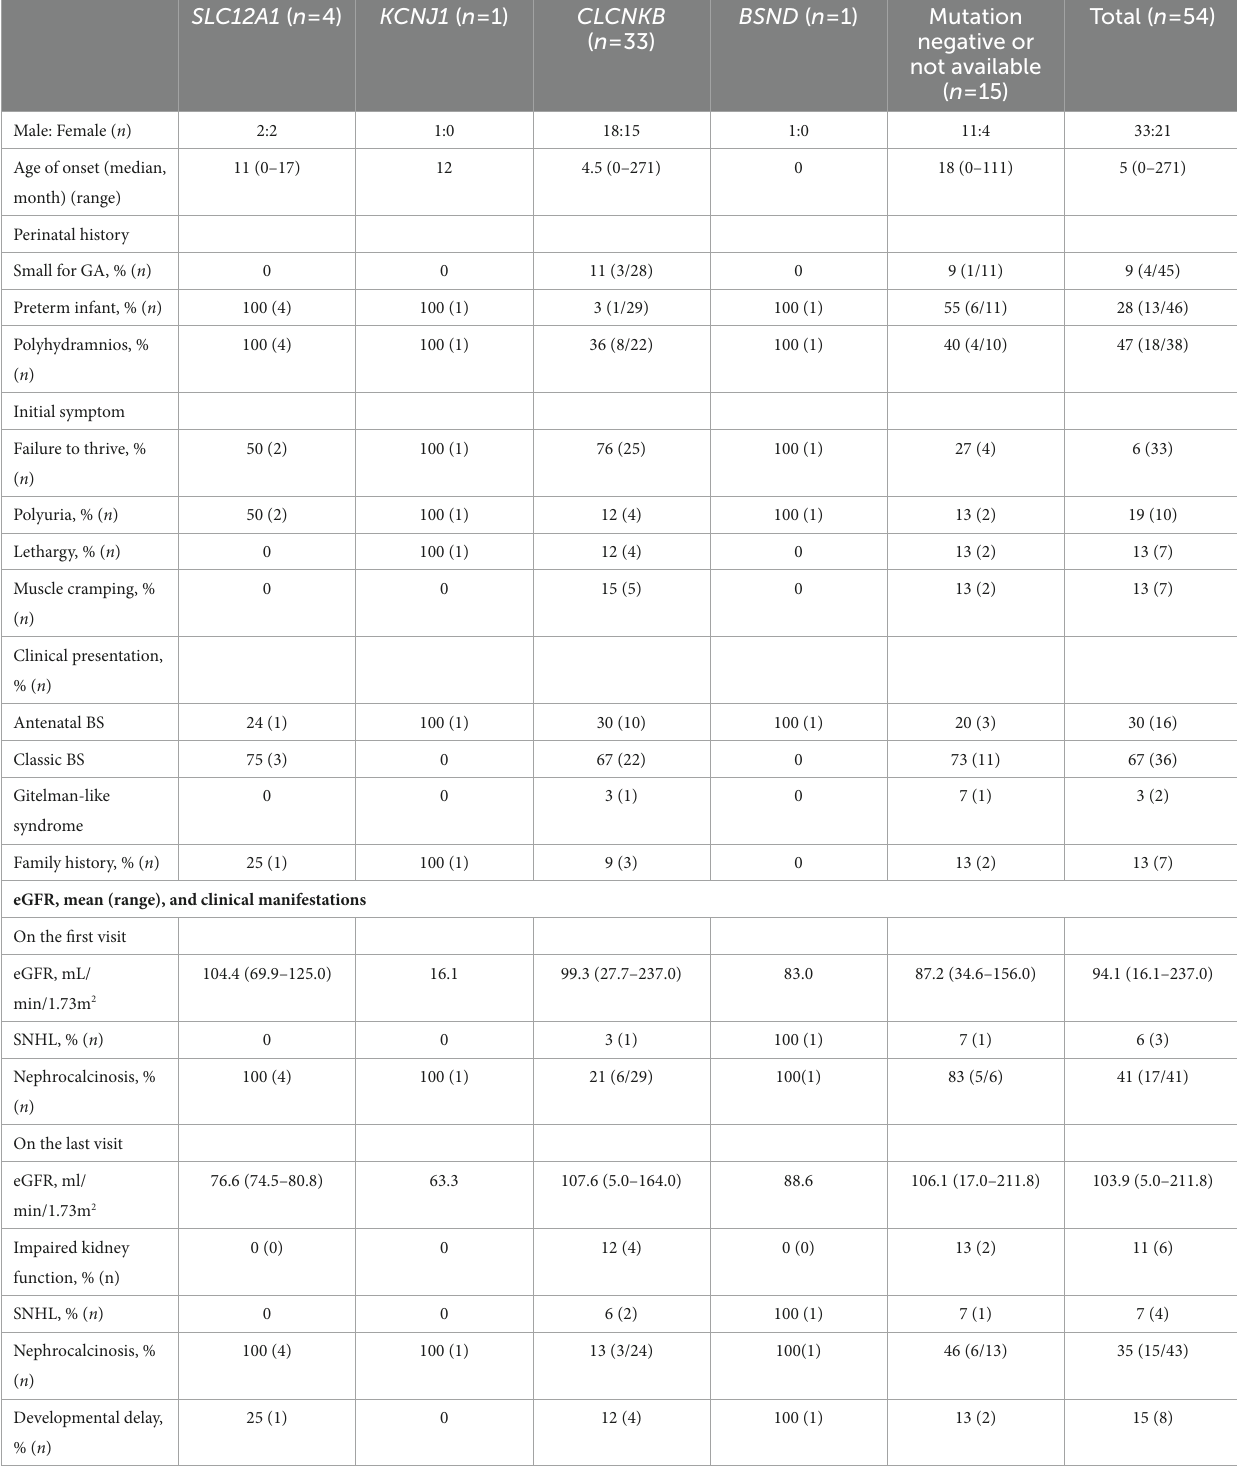
TABLE 1 Clinical characteristics according to genetic causes of Bartter syndrome